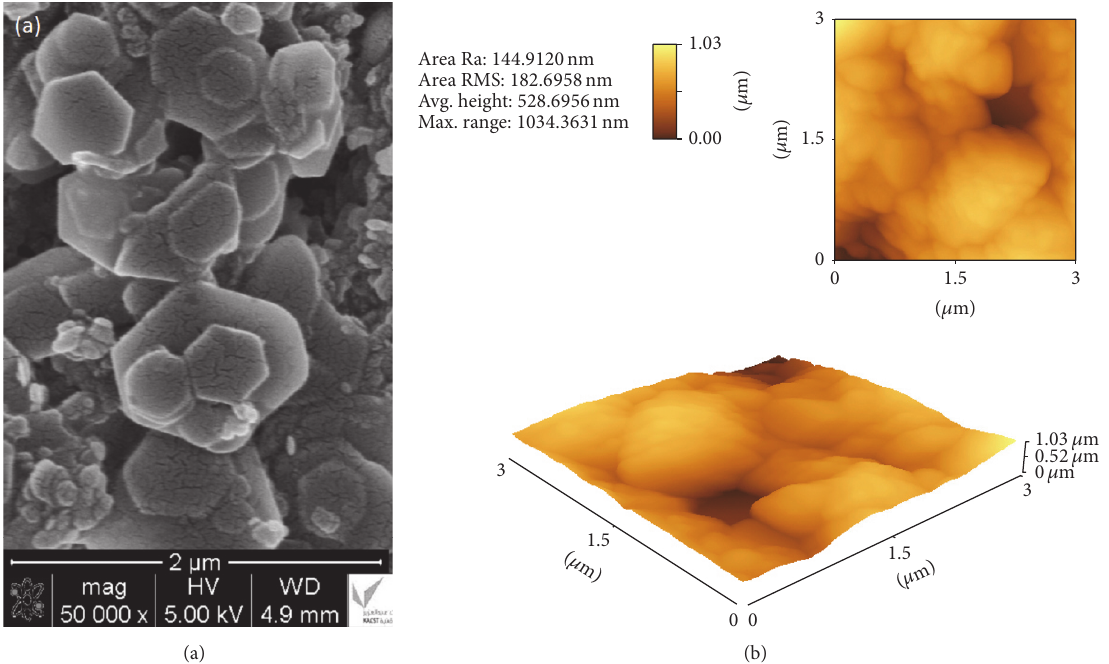
Figure 1: (a) The scanning electron microscopic image for the BN films being magnified 5000 times; (b) the atomic force microscopy images for the BN